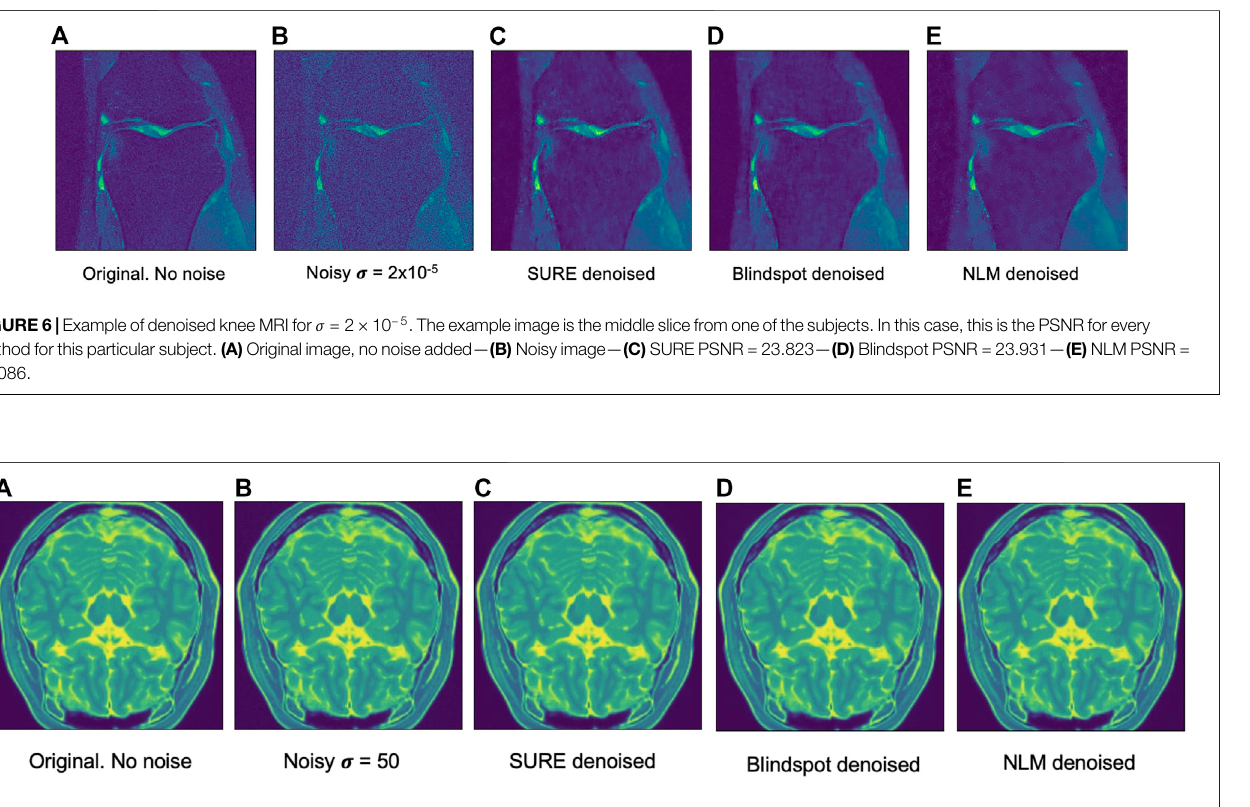
FIGURE 7 | Example of denoised brain MRI for σ (cid:1) 50. The example image is the middle slice from one of the subjects. In this case, this is the PSNR for every methodforthisparticular subject. (A) Originalimage, nonoiseadded — (B) Noisyimage — (C) SUREPSNR (cid:1) 43.883 — (D) BlindspotPSNR (cid:1) 44.731 — (E) NLMPSNR (cid:1)